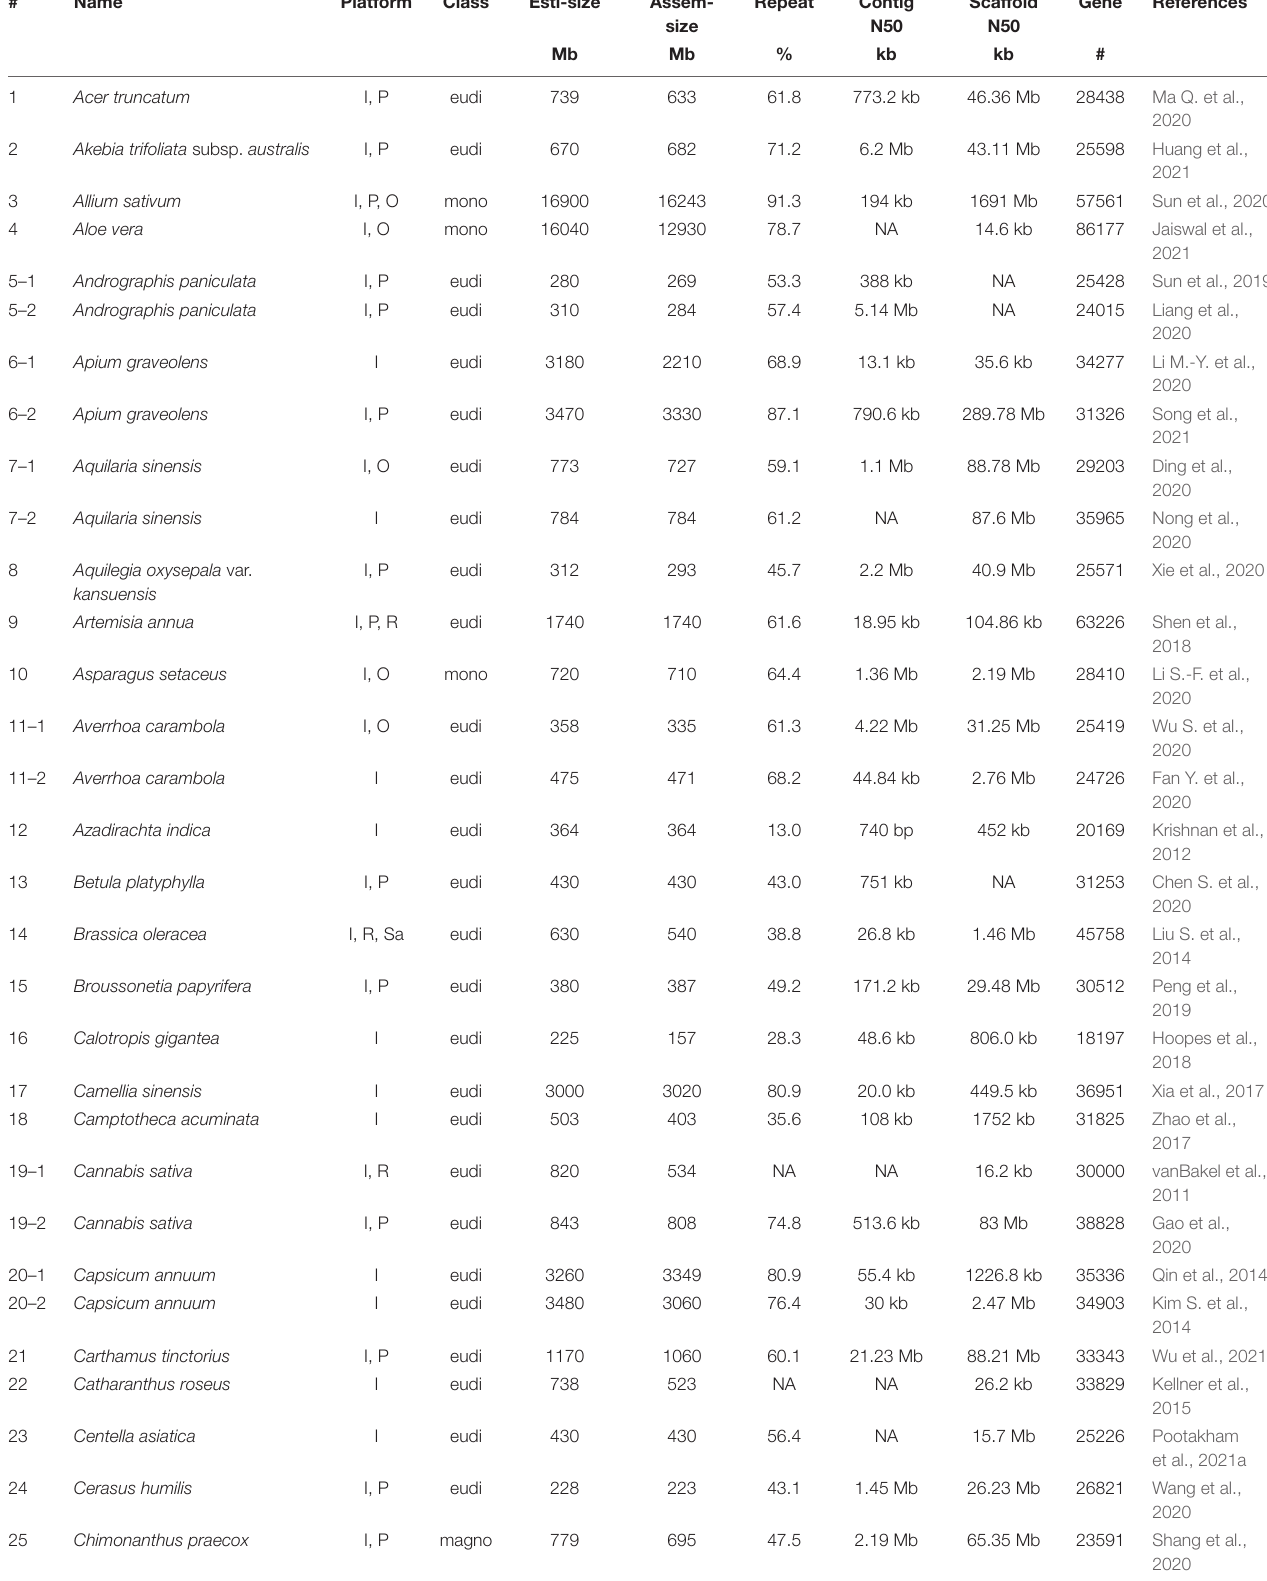
TABLE 1 | The statistical results of medicinal plant genome published